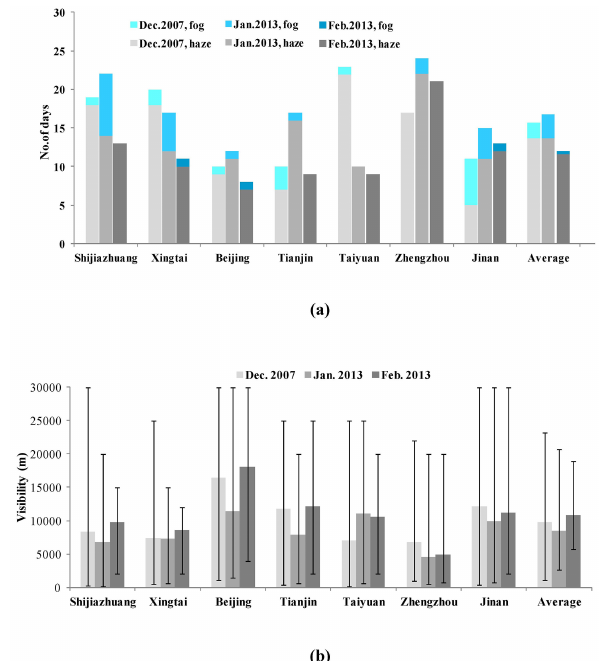
Fig. 3. The monthly total number of (a) hazy and foggy days and (b) the average visibilities in the seven representative cities in northern China in December 2007, and January and February 2013. The line in (b) indicates the minimum and maximum daily